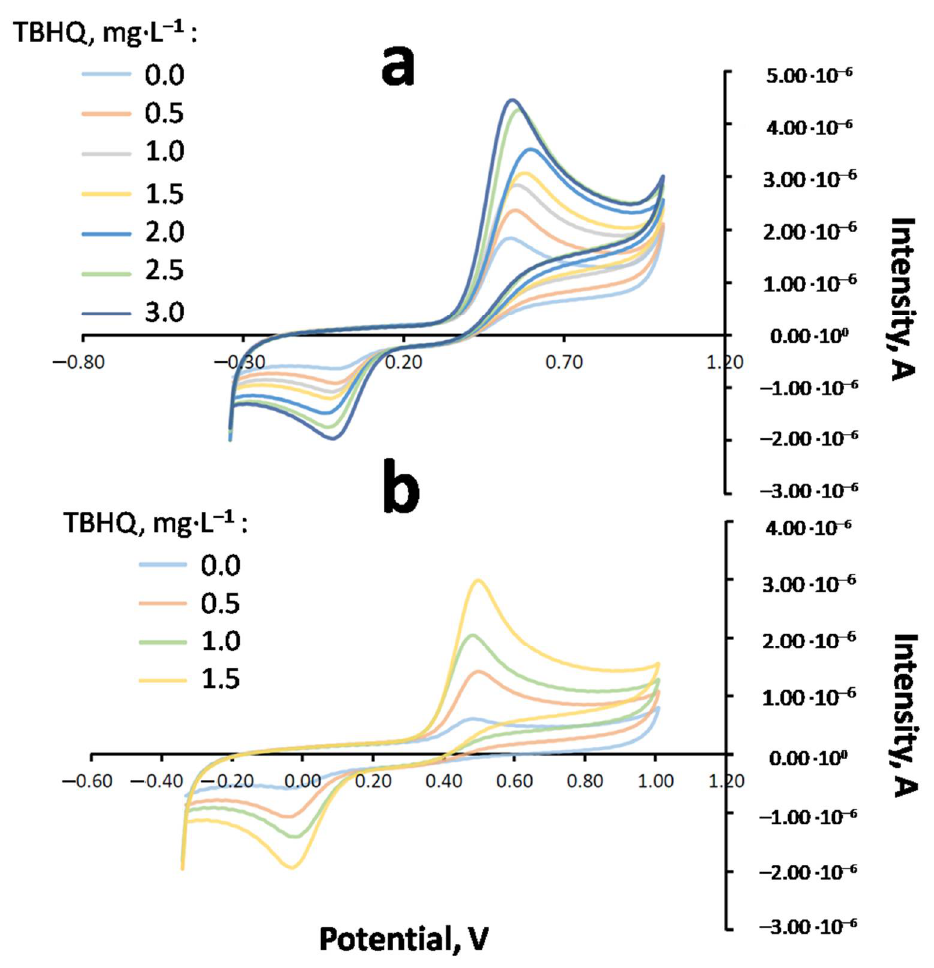
Figure 8. Cyclic voltammograms with standard additions (498 mg · L − 1 TBHQ) for FOBL with TBHQ (1044 mg · L − 1 ) through ( a ) emulsion medium and( b ) dispersive microextraction.